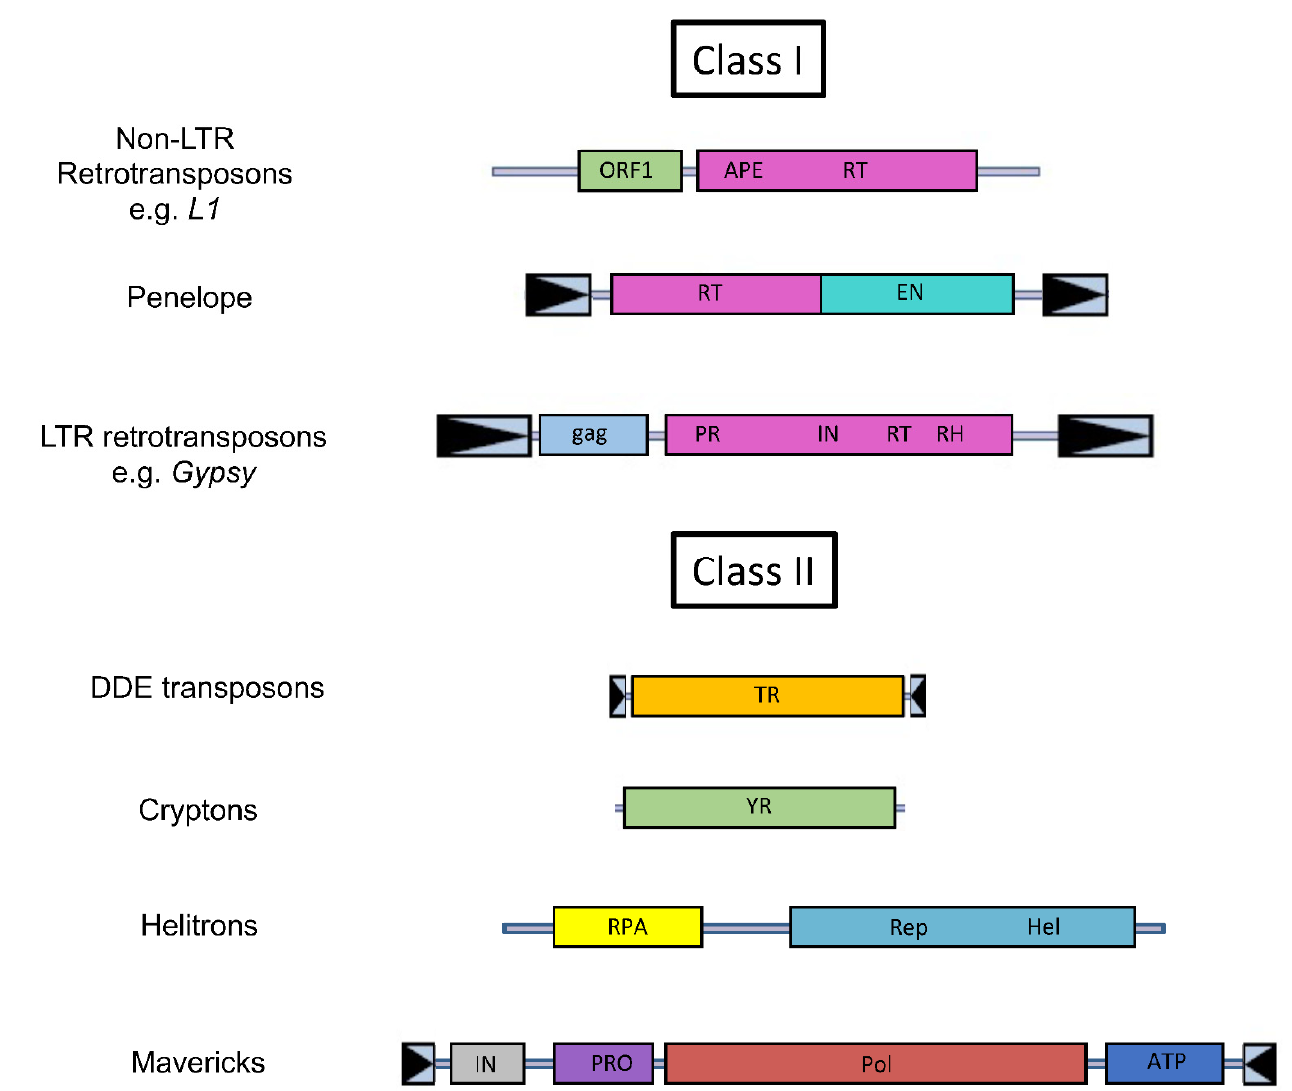
Figure 1. Schematic representation of the main categories of autonomous transposable elements. The elements are not drawn to scale. The following abbreviations are used: APE, apurinic endonuclease; RT, reverse transcriptase; ORF1, open-reading frame 1; EN, GIY-YIG endonuclease; gag, gag gene; PR, proteinase; IN, integrase; RH, RNase H domain; TR, transposase; YR, tyrosine recombinase; RPA, replication protein A; Rep, replication initiation domain; Hel, helicase; PRO, cysteine protease; Pol, protein-primed type B DNA polymerase; ATP, ATPase. The boxed arrows represent terminal repeats.